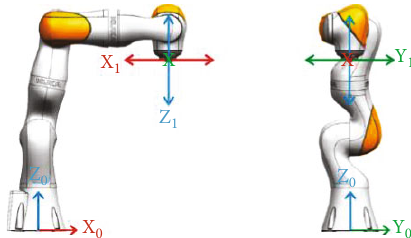
Figure 2: World frame and fl ange frame of the